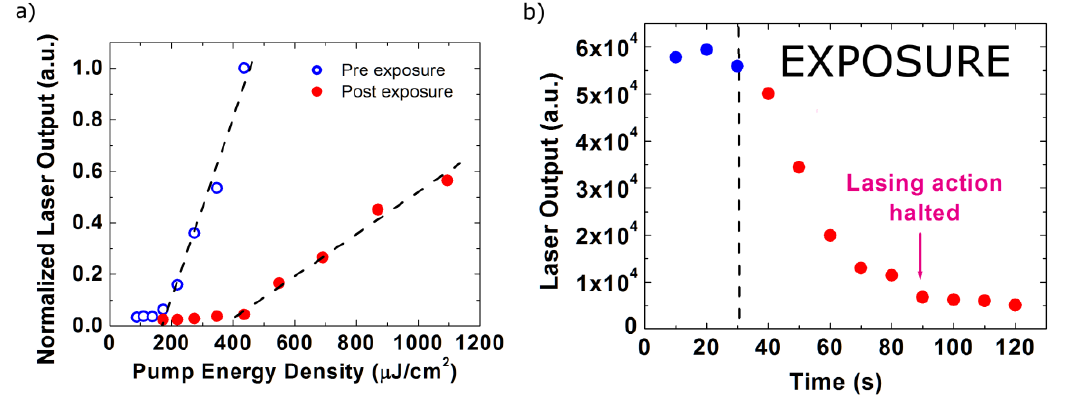
Figure 6. (a) Power characteristics of a PIM laser before and after a 5-min exposure; (b) Laser output dynamics during a 90-s